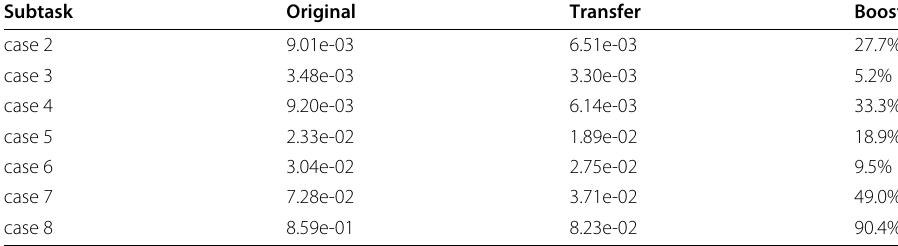
Table 9 Performance boost of GP-PINN on the Helmholtz benchmarks using transfer learning